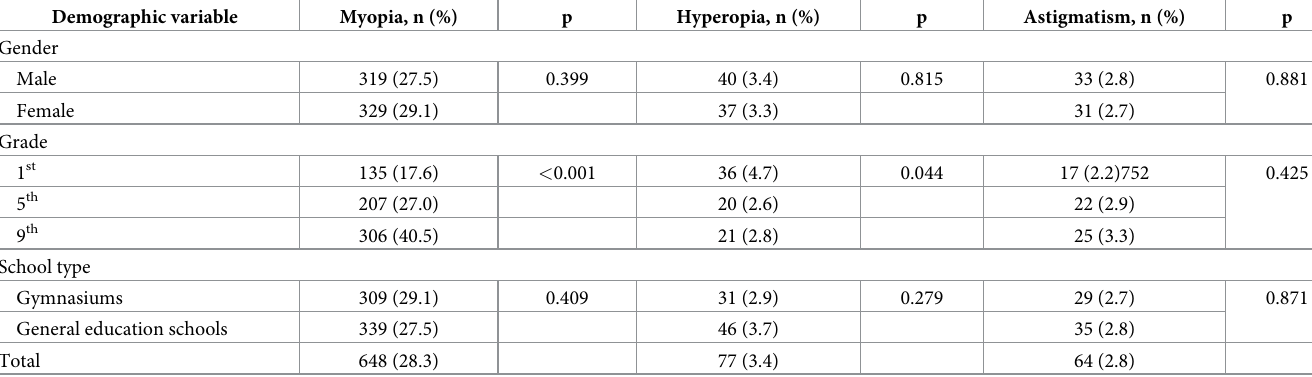
Table 2. The prevalence of different types of refractive errors by gender, school types and grades.